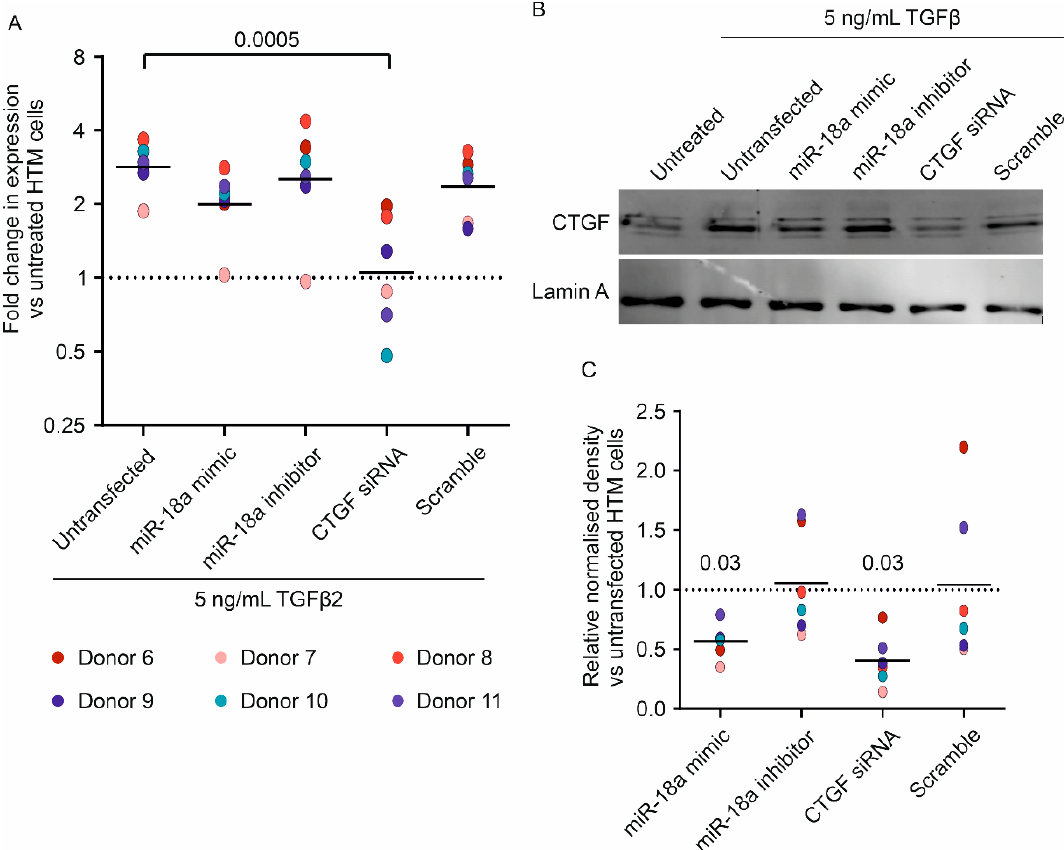
Figure 2. miR-18a-5p mimic and CTGF siRNA reduce CTGF expression. ( A ) CTGF expression was measured by RT-qPCR, relative to untreated cells, and normalised to the geomean of RPLP0 and GAPDH. Individual values for donors 6 to 11 are shown with a bar representing the median. The line at y = 1 represents the level of expression in untreated cells. Data were analysed by the Friedman test with Dunn’s multiple comparisons test, n = 6. ( B ) Representative Western blots of CTGF and lamin A. ( C ) Densitometry analysis of CTGF blots, normalised to lamin A. Individual values are shown with a bar representing the median. The line at y = 1 represents the level of TGF β 2-treated cells. Data were analysed by Wilcoxon signed-rank test comparing median values to a hypothetical value of 1, n =